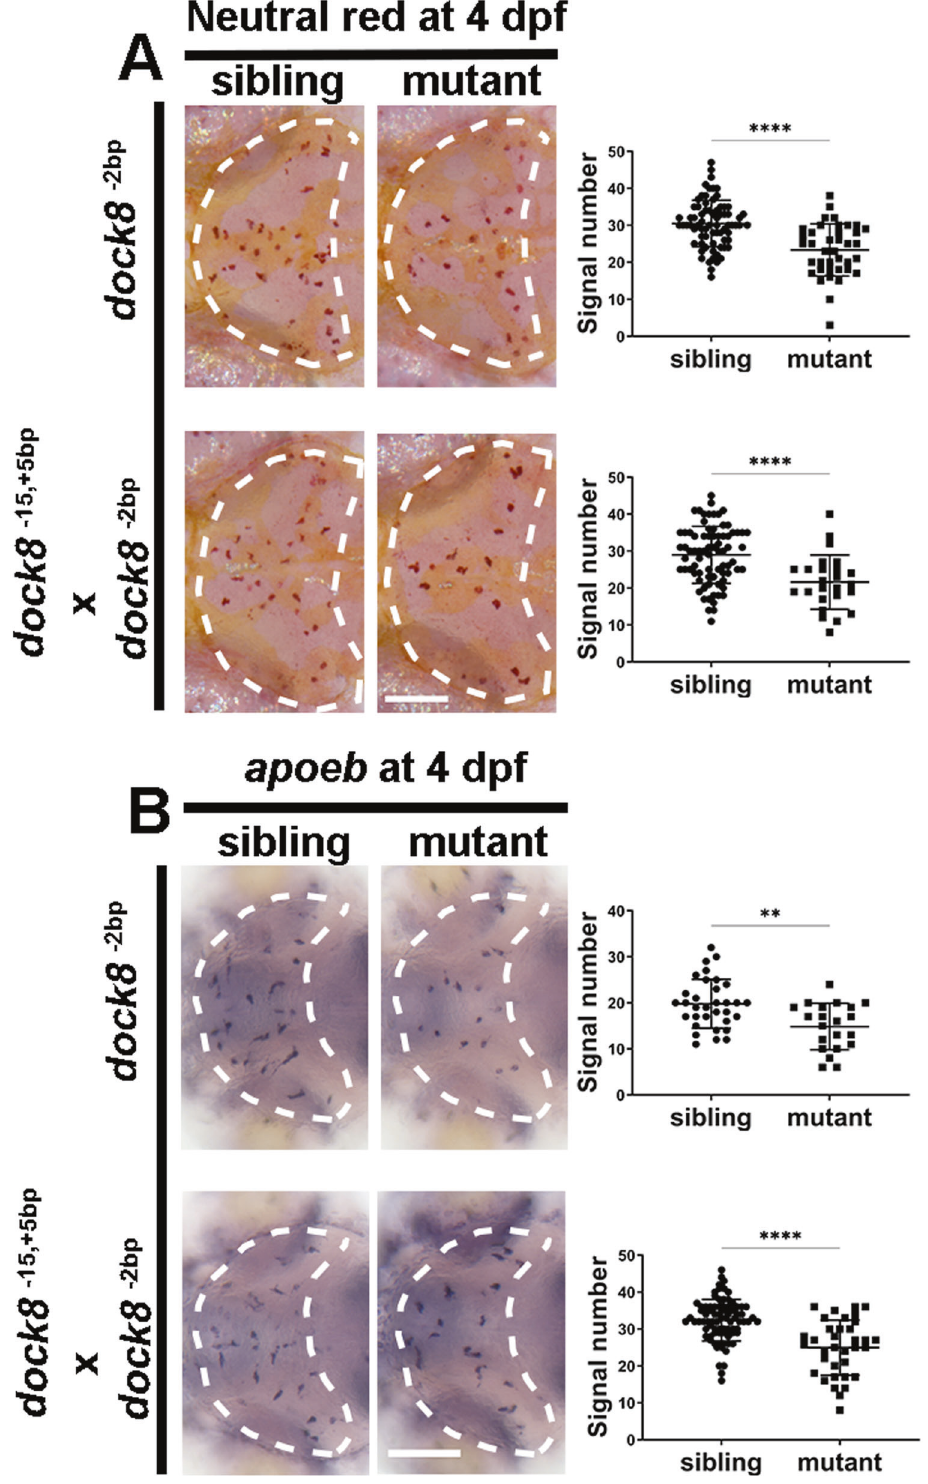
Fig. 3 dock8 is the causative gene of microglia de fi ciency. A Representative images and quanti fi cation of 4 dpf NR signals of dock8 -2bp mutants, dock8 -15, + 5bp/-2bp compound mutants and siblings. B Representative images and quanti fi cation of 4 dpf apoeb WISH signals of dock8 -2bp mutants, dock8 -15, + 5bp/-2bp compound mutants and siblings. Group sizes were at least n = 30 zebra fi sh embryos. Each dot represents one larva. White dashed lines indicate the optic tectum. Scale bar = 100 µm. Data were analyzed by unpaired Student ’ s t -tests. ** P ≤ 0.01 ; **** P ≤ 0.0001 .